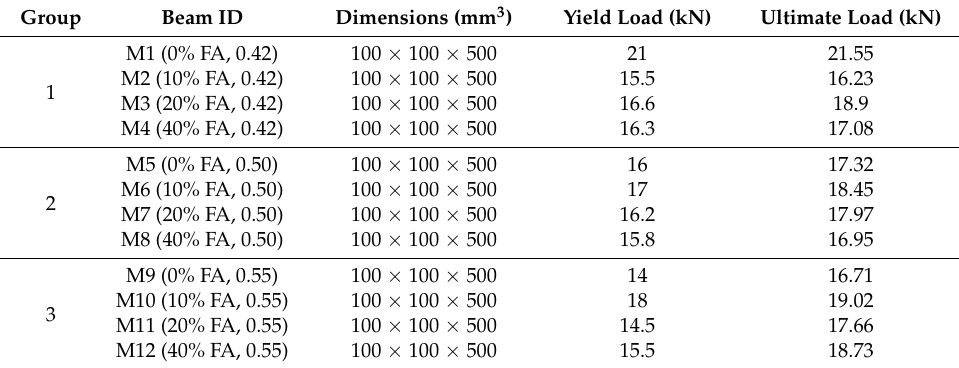
Table 4. Yield load and ultimate load of